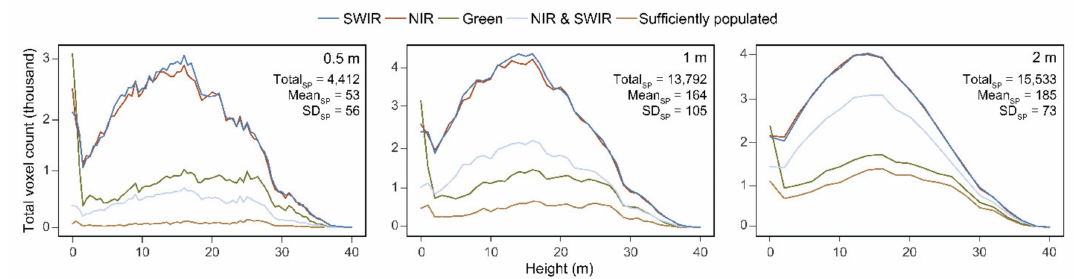
Figure 4. Total count of voxels for all plots containing at least one point for each M-ALS wavelength individually, where NIR and SWIR were both contained within a voxel, and su ffi ciently populated (SP) voxels with points from all bands. Descriptive statistics indicate the total number of SP voxels, as well as the mean and standard deviation (SD) of SP voxels per